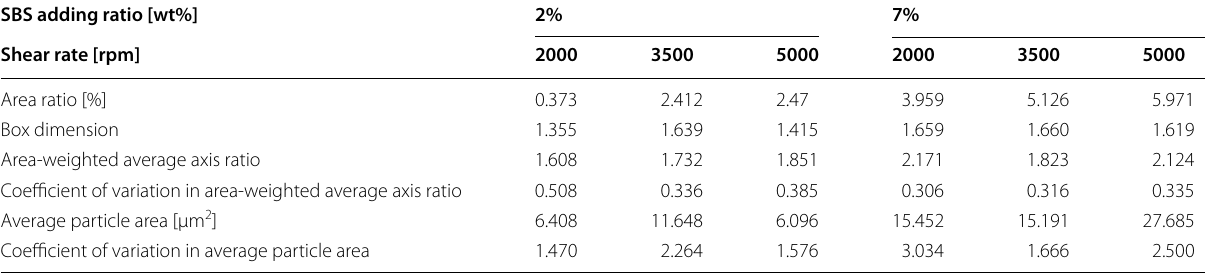
Table 5 Influence of shearing rate on the micro-morphologies of SBS in the mix SBS adding ratio [wt%]